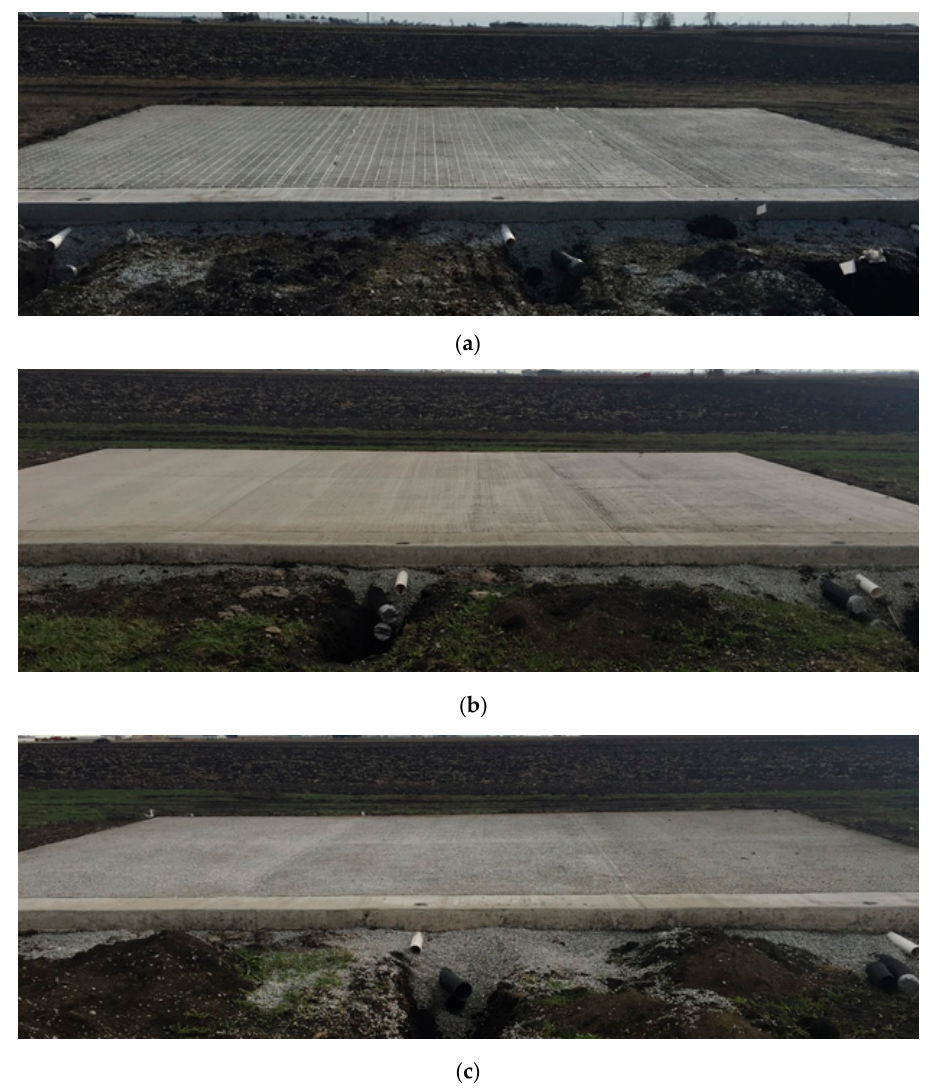
Figure 3. The pavement study site at the University of Illinois Urbana-Champaign is equipped with three pavement types, from top to bottom, ( a ) JW, ( b ) IC, and ( c ) PC pavement systems.